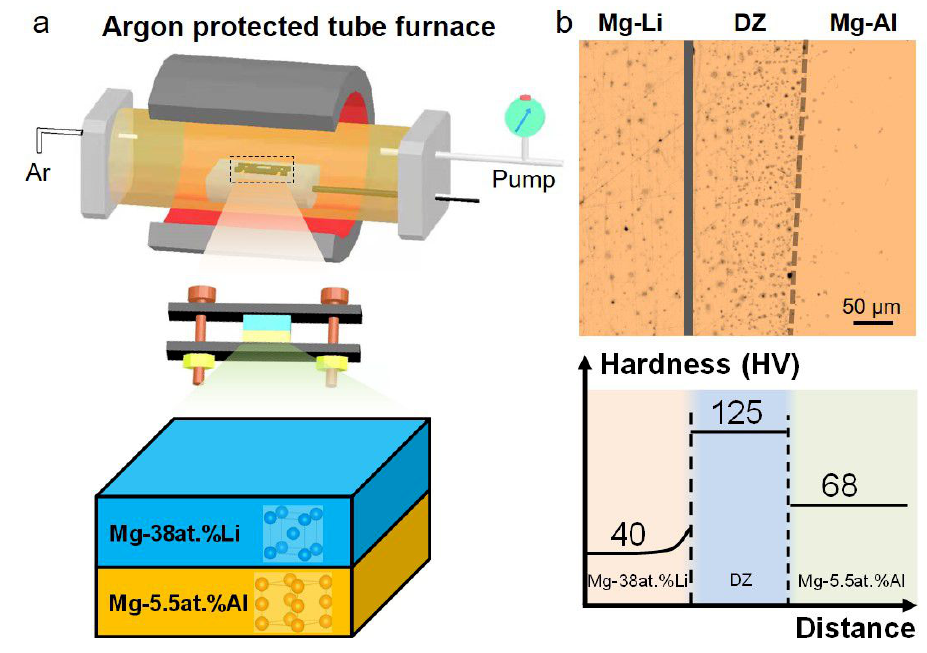
Figure 1. ( a ) Schematic illustration of the diffusion couple apparatus. ( b ) Optical micrograph and hardness profile of the Mg–38at.%Li/Mg–5.5at.%Al coupled sample. A clear diffusion zone (DZ) can be seen on the Mg–5.5at.%Al side after diffusion coupling. The Vickers hardness of Mg–38at.%Li and Mg–5.5at.%Al matrixes are 40 ± 2 HV and 68 ± 3 HV, and the hardness of the diffusion zone is 125 ± 5 HV. The mean value of hardness is displayed in the